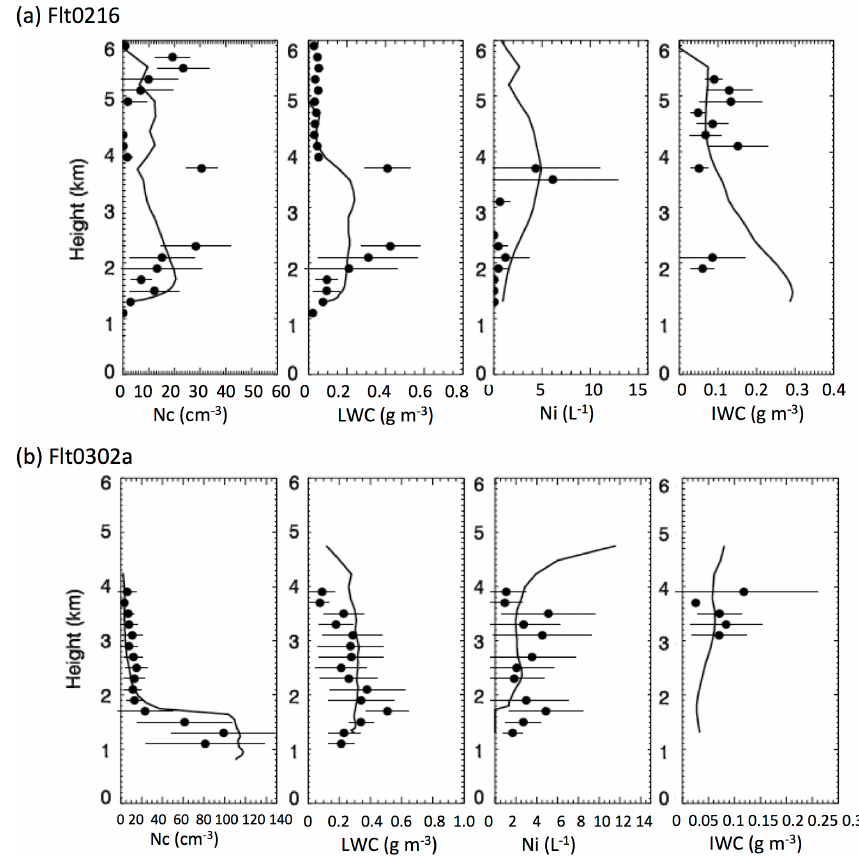
Fig. 5. Comparison of the modeled cloud droplet number concentration ( N c ), liquid-water content (LWC), ice particle number concentration ( N i ), and ice-water content (IWC) with aircraft measurements (a) for flt0206 on FEB16 and (b) for flt0302a on MAR02. The black dots denote the observed data. N c is from CDP, LWC and IWC are from the WCM measurements, and N i is from 2DS. The bars denote standard deviation. The model results are from the base run (LoCCN&Dust). The model results are averaged over the cloudy points identified by the detection limit of each instrument in the aircraft-measurement domain instead of the flight track due to the extreme heterogeneous nature of the clouds in this